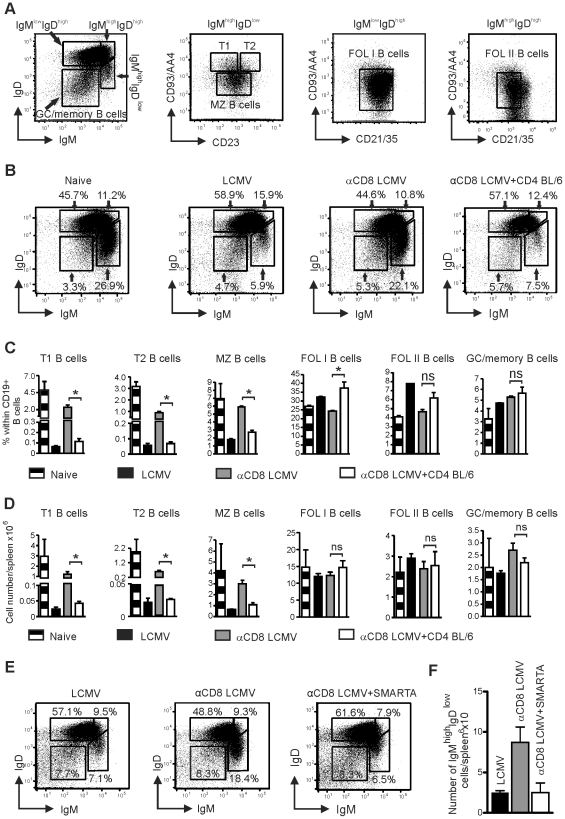
Analysis of the effect of CD4+ T cells on B cell subsets in spleen.(A) Example of splenic B cell subtype analysis. Single cell suspension of the spleen was first gated on lymphocytes by forward and side scatter and afterwards on CD19+ B cells. CD19+ B cells were divided in IgMlowIgDlow GC/memory B cells, T1 B cells (CD19+IgMhighIgDlowCD93/AA4+CD23−), T2 B cells (CD19+IgMhighIgDlowCD93/AA4+ CD23+), MZ B cells (CD19+IgMhighIgDlowCD93/AA4−CD23−), FOL I B cells (CD19+IgMlowIgDhighCD21/35int), and FOL II B cells (CD19+IgMhighIgDhighCD93/AA4−/lowCD21/35int) cells. (B–D) BL/6 mice, BL/6 mice depleted of CD8+ T cells and BL/6 mice depleted of CD8+ T cells receiving 1.5×107 purified LCMV-immune CD4+ T cells were infected with LCMV. On day 11 after infection B cell subsets were analyzed as described in (A). (B) Analysis of IgM and IgD subtypes. Numbers indicate percentage (mean) within CD19+ B cells (n = 3 per group). (C) Percentage within CD19+ B cells and (D) absolute number of T1, T2, MZ, FOL I, and FOL II, and GC/memory B cells in the spleen. BL/6 naïve mice served as control. Mean ± SEM (error bars) of 3 animals per group is shown. For B–D, one representative experiment of 3 independent experiments is shown. (E, F) BL/6 mice, BL/6 mice depleted of CD8+ T cells and BL/6 mice depleted of CD8+ T cells receiving 1×107 splenocytes of naïve SMARTA mice were infected with LCMV. On day 11 after infection, CD19+ splenocytes were analyzed for IgM and IgD subtypes. (E) Percentage (numbers indicate mean) within CD19+ B cells and (F) absolute number of IgMlowIgDhigh, IgMhighIgDhigh, IgMhighIgDlow and GC/memory B cells were determined per spleen. Mean ± SEM (error bars) of 2–3 animals per group are shown.